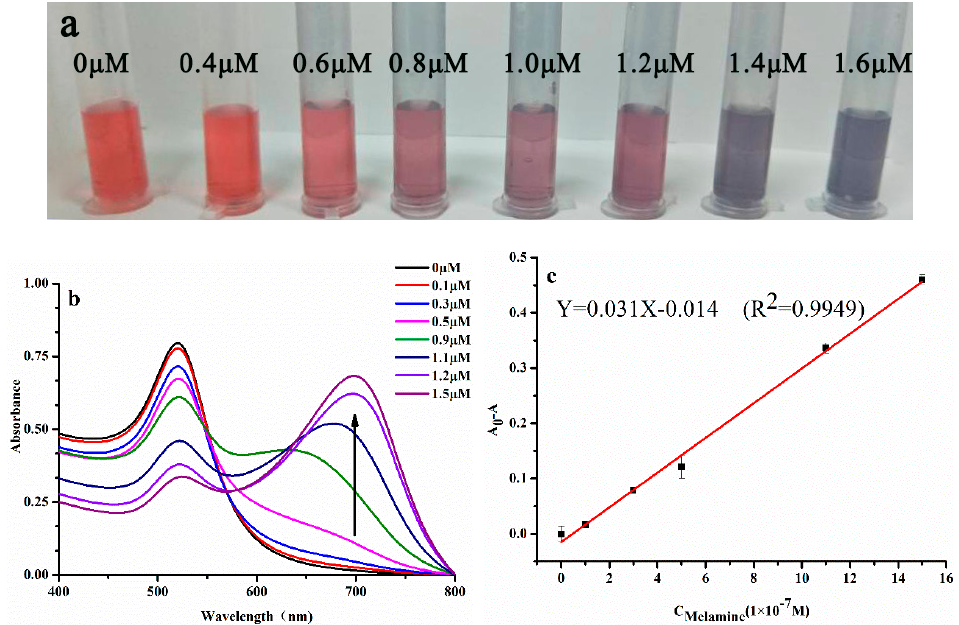
Figure 3. ( a ) The visual color change of the AuNPs with different concentrations of melamine; they were marked on the tubes; ( b ) absorption spectra of CPNs-AuNPs with different concentrations of melamine. AuNPs: 2.37 nM; ( c ) a linear relationship (at 522 nm) between A 0 –A and melamine concentrations; A 0 and A are the absorbance in the absence and presence of melamine, respectively.